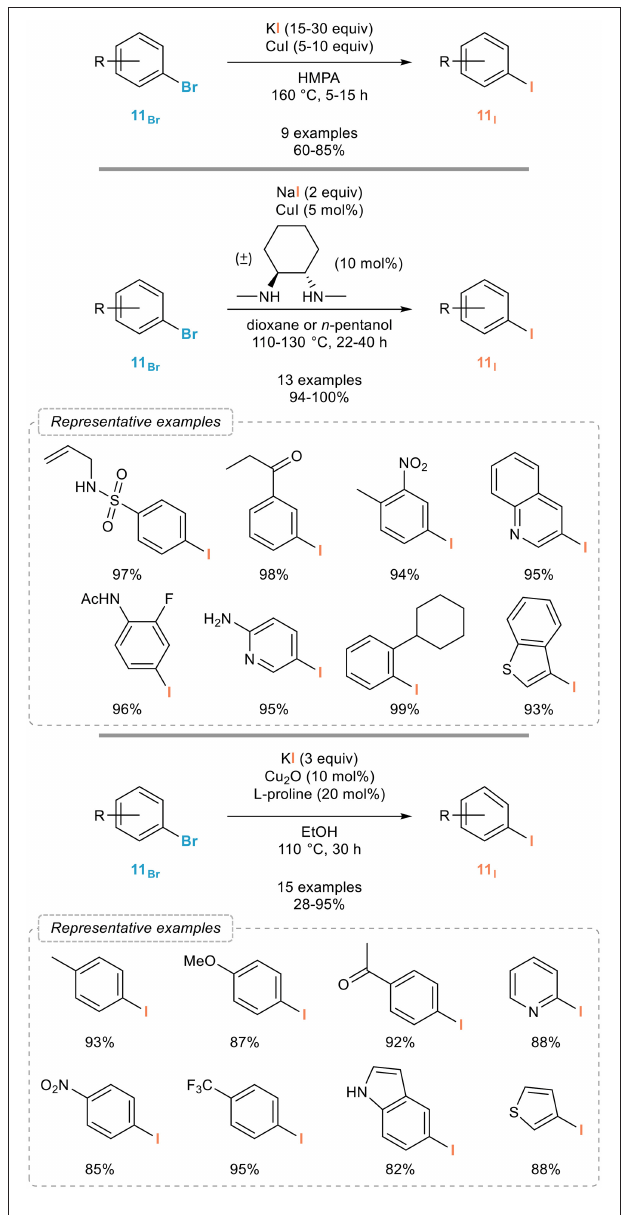
FIGURE 5 | Copper-mediated/catalyzed aromatic Finkelstein